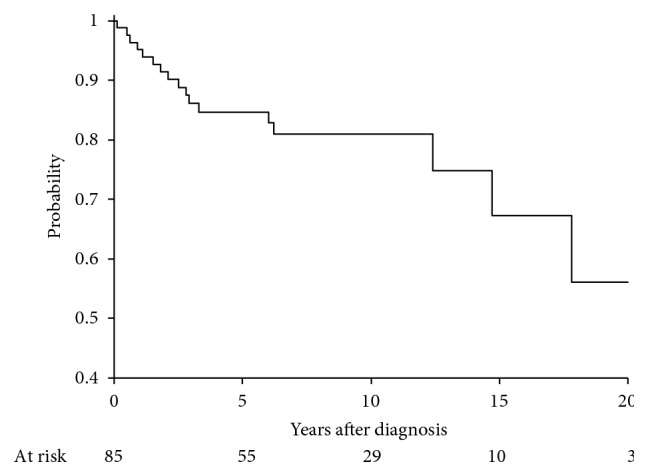
Distant metastases-free survival at 5 years, 84.7 (74.5–91.0).